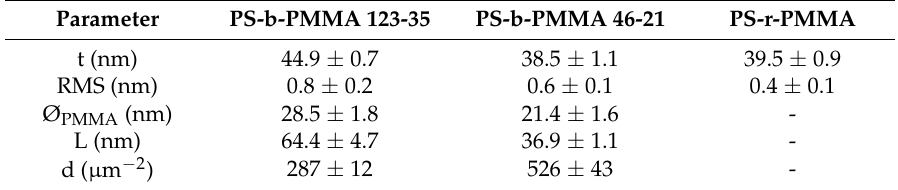
Figure 2. Representative topographic AFM images of ordered thin films of ( A ) PS-b-PMMA 123-35 and ( B ) PS-b-PMMA 46-21 diblock copolymers and ( C , D ) corresponding Voronoi diagrams indicating the defects in the ordered structures. Scale bars: 400 nm. Table 1. Characteristic parameters of copolymer thin films. PS-b-PMMA 123-35, PS-b-PMMA 46-21 and PS-r-PMMA were spun coated at 7.5 mg/mL, 5 mg/mL, and 5 mg/mL, respectively. After annealing at 220 ◦ C for 3 h, film thickness (t), RMS roughness (RMS), diameter of PMMA cylinders (Ø PMMA ), interdomain spacing (L), and density of nanodomains (d) were calculated from AFM images. Values are given as the mean ± standard deviation and are obtained from images of 2 µ m x 2 µ m in size. At least 3 images per sample from 3 independent experiments of the different polymer compositions were